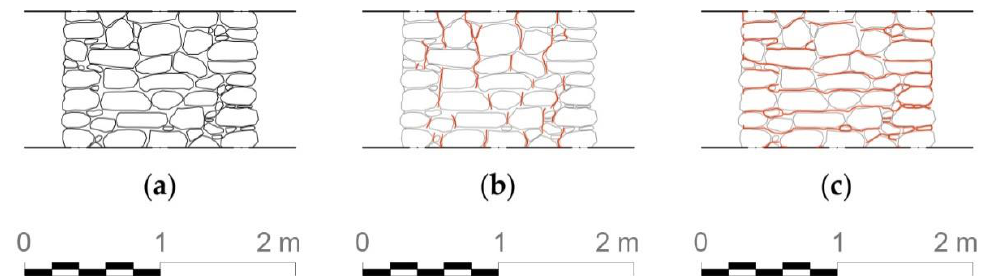
Figure 15. Example of joint assessment in the Casasola tower. The image analysed is the section of wall ( a ) from which the vertical ( b ) and horizontal ( c ) joints are highlighted.